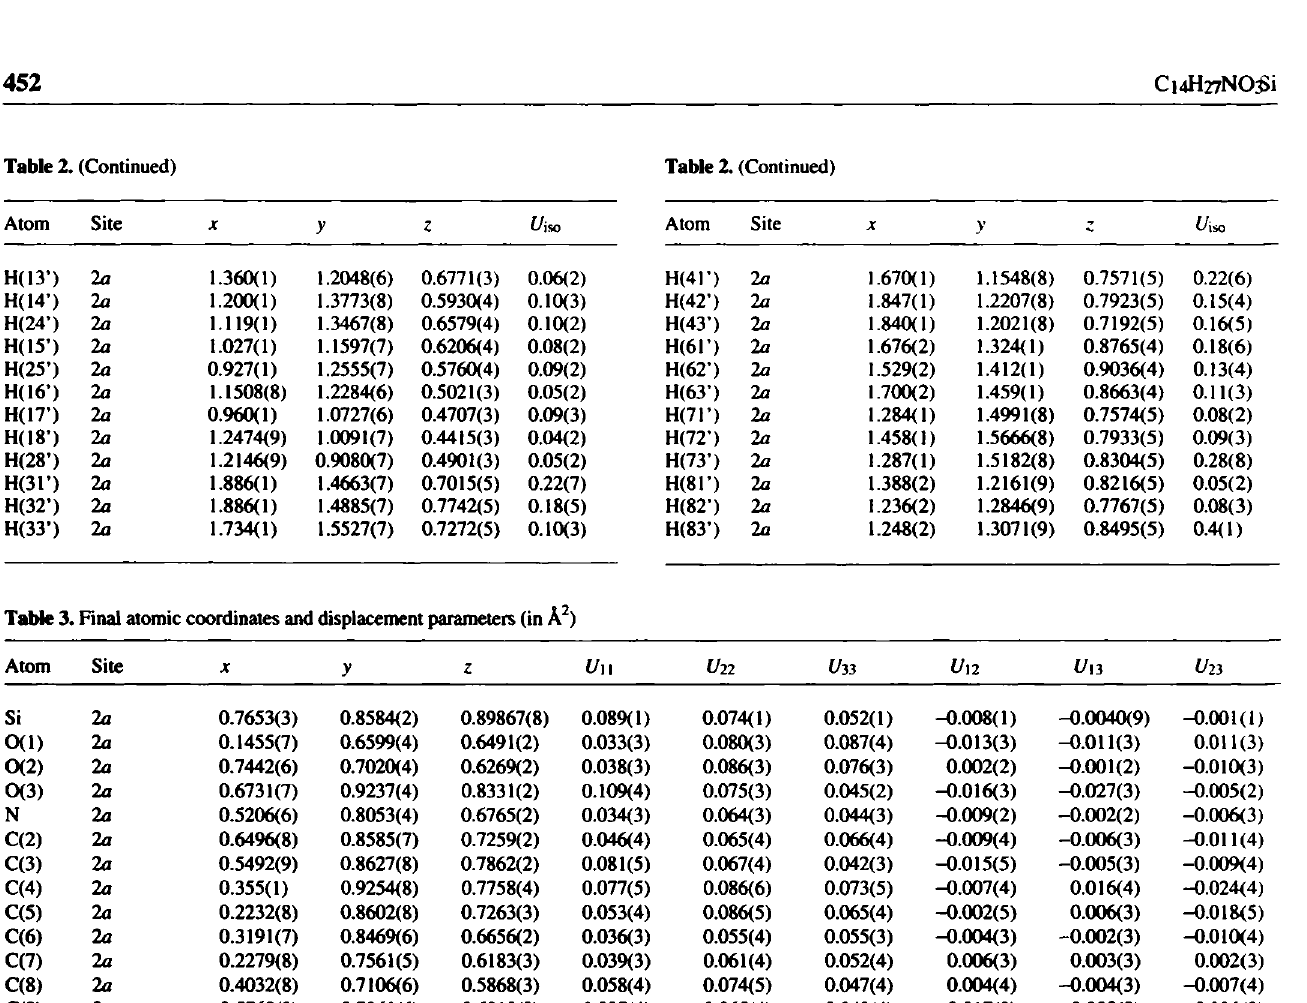
Table 3. Final atomic coordinates and displacement parameters (in Ä 2